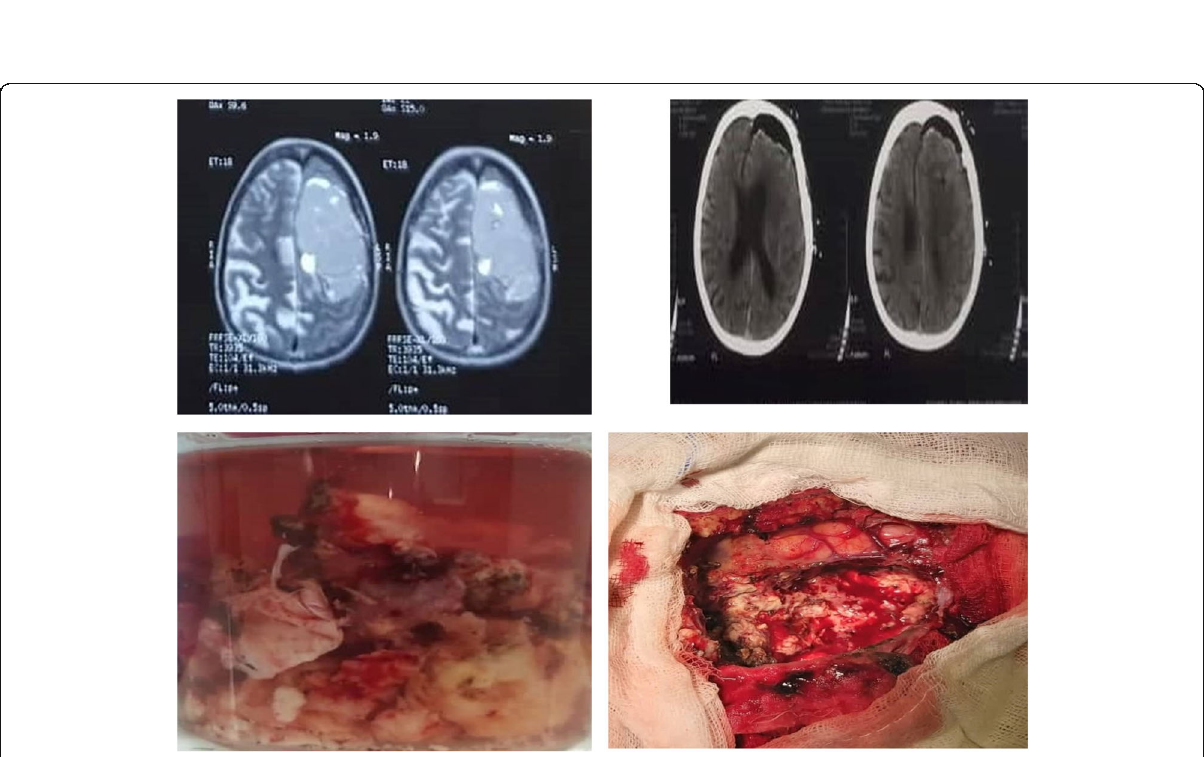
Fig. 3 Left frontoparietal giant convexity meningioma. Upper left, axial T2-weighted image showing the lesion which is hyperintense to the brain with minimal mass effect. Upper right image, 1 day postoperative CT brain follow-up showing complete removal of the lesion. Lower left, tumor pieces for histopathological analysis. Lower right, intraoperative view showing the tumor during resection and the tumor brain